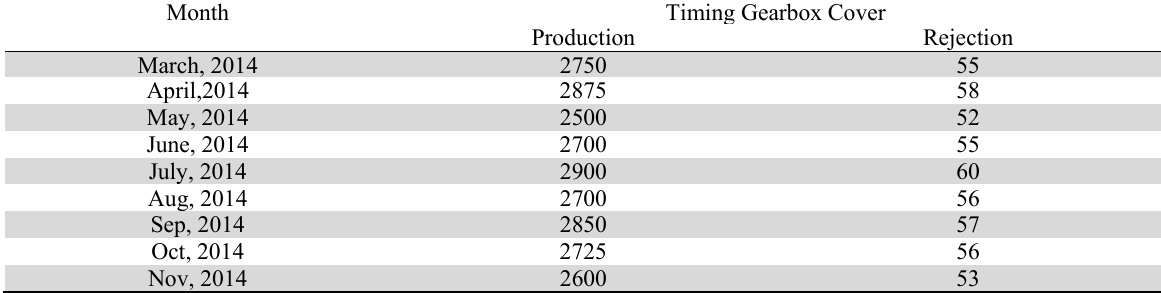
Monthly Production / rejection trend for Improved Process